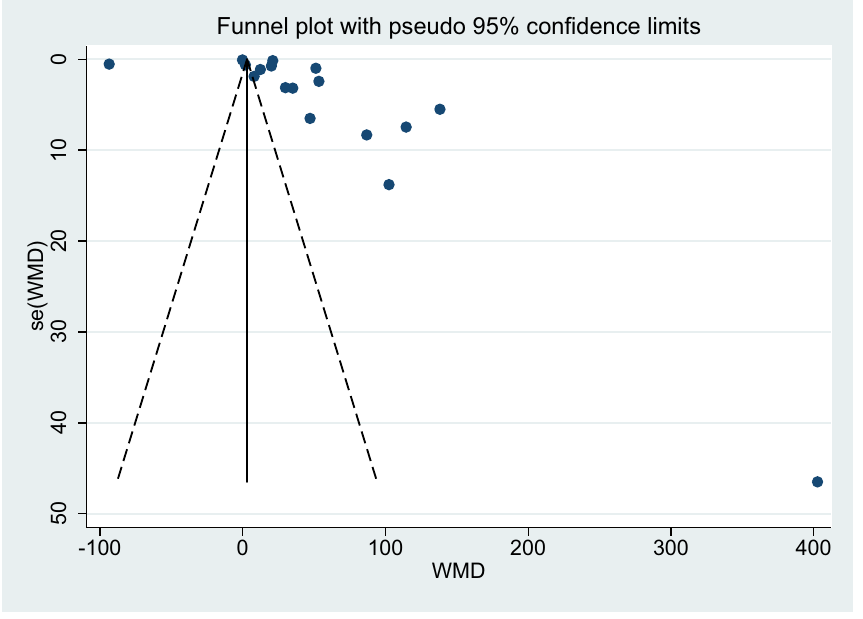
Figure 18. Funnel plot demonstrating the distribution of the effect size (WMD) and standard error of the effect size (seES) among studies included in the meta-analysis of uncomplicated malaria and controls.